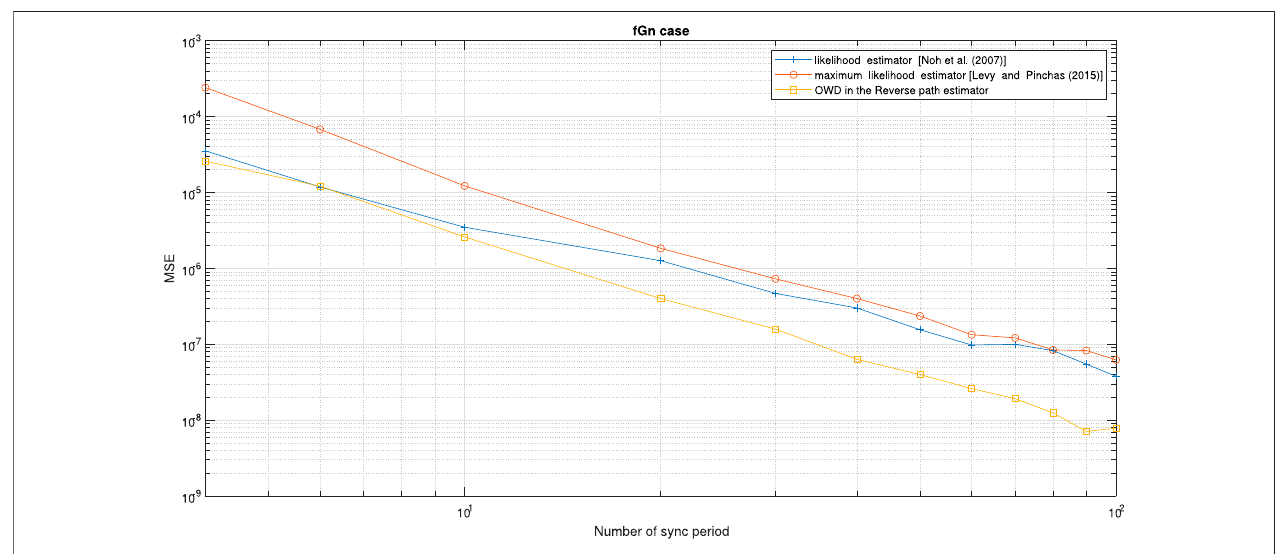
FIGURE10 | Performance (MSE) comparison between the OWDclock skew estimator forthe Reverse path ( Eq. 62 ),likelihood clock skew estimator proposed by Noh et al. [5] and maximum likelihood clock skew estimator proposed by Levy and Pinchas [7]. The PDV is an fGn process. α = 50 ppm , Q = 5 ms , ) , H = 0.7, d σ 2 (cid:2) 1 . 6 e − 7 [ sec 2 ] , σ 2 (cid:2) 4 e − 8 [ sec 2 ] . The results were obtained for 100 Monte-Carlo trails. T syn (cid:2) 15 . 6 ms ( 64 packet ω 1 ω 2 ms = 5.5 ms , d sm = 5 ms , sec